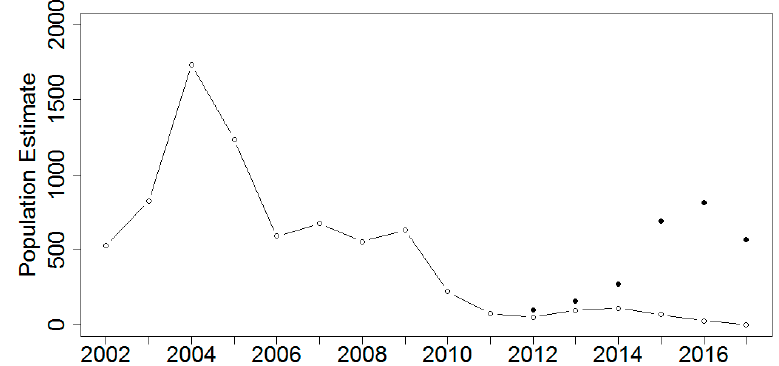
Figure 1. Estimated population size of St. Francis’ satyrs during the second flight period from 2003–2017 outside of artillery impact areas on Fort Bragg, NC. Closed circles represent population size when restored sites were included.